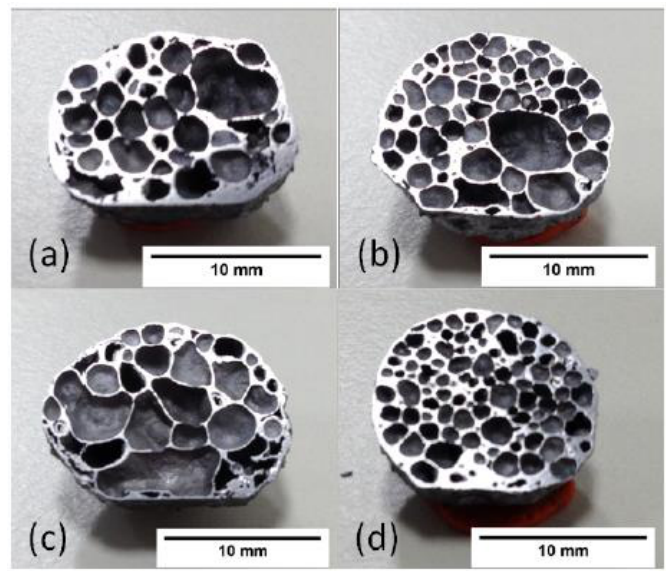
Figure 6. Cross-sections showing the pore structure of ( a ) AlSi7Mg5, ( b ) AlSi8Mg4, ( c ) AlSi9Mg3, and ( d ) AlSi9Mg5 after foaming and cutting into two pieces along a plane perpendicular to the sample substrate.